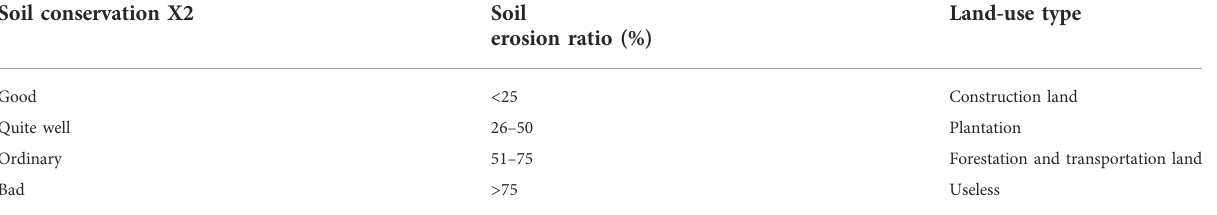
TABLE 3 The soil conservation classi fi cation and land use